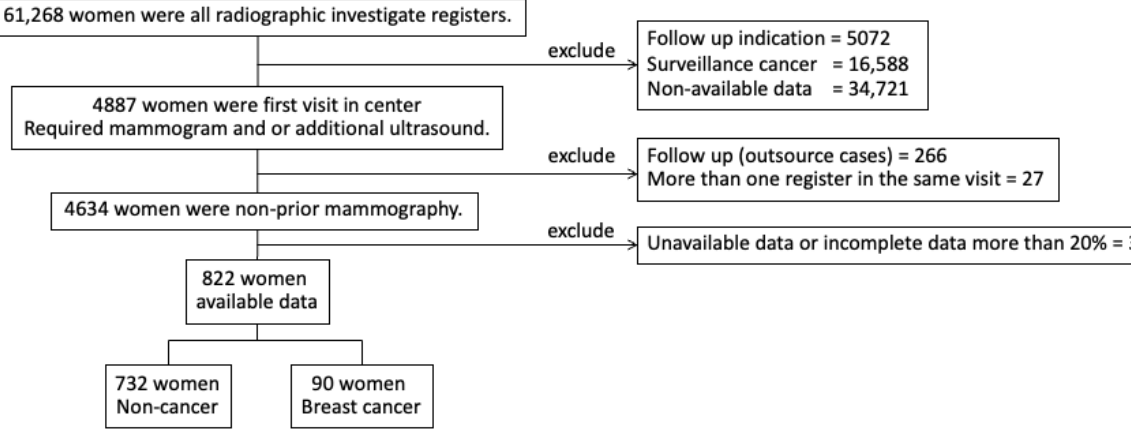
Figure 1. Participant enrolment.